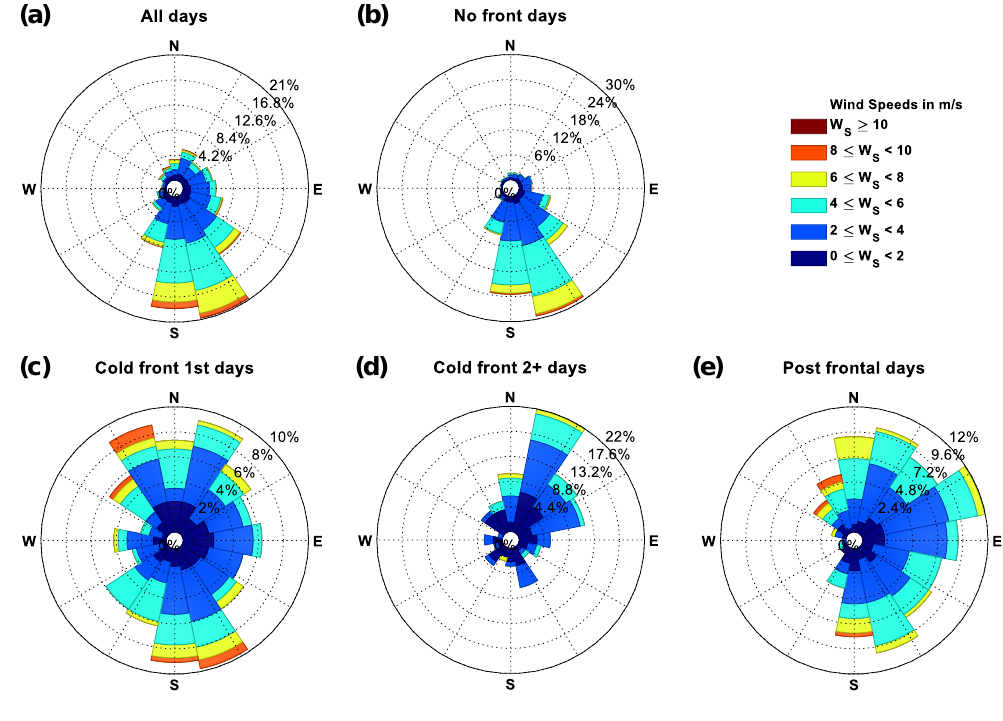
Figure 7. Wind rose during ( a ) all days; ( b ) no front days; ( c ) cold front 1st days; ( d ) cold front 2+ days; and ( e ) post frontal